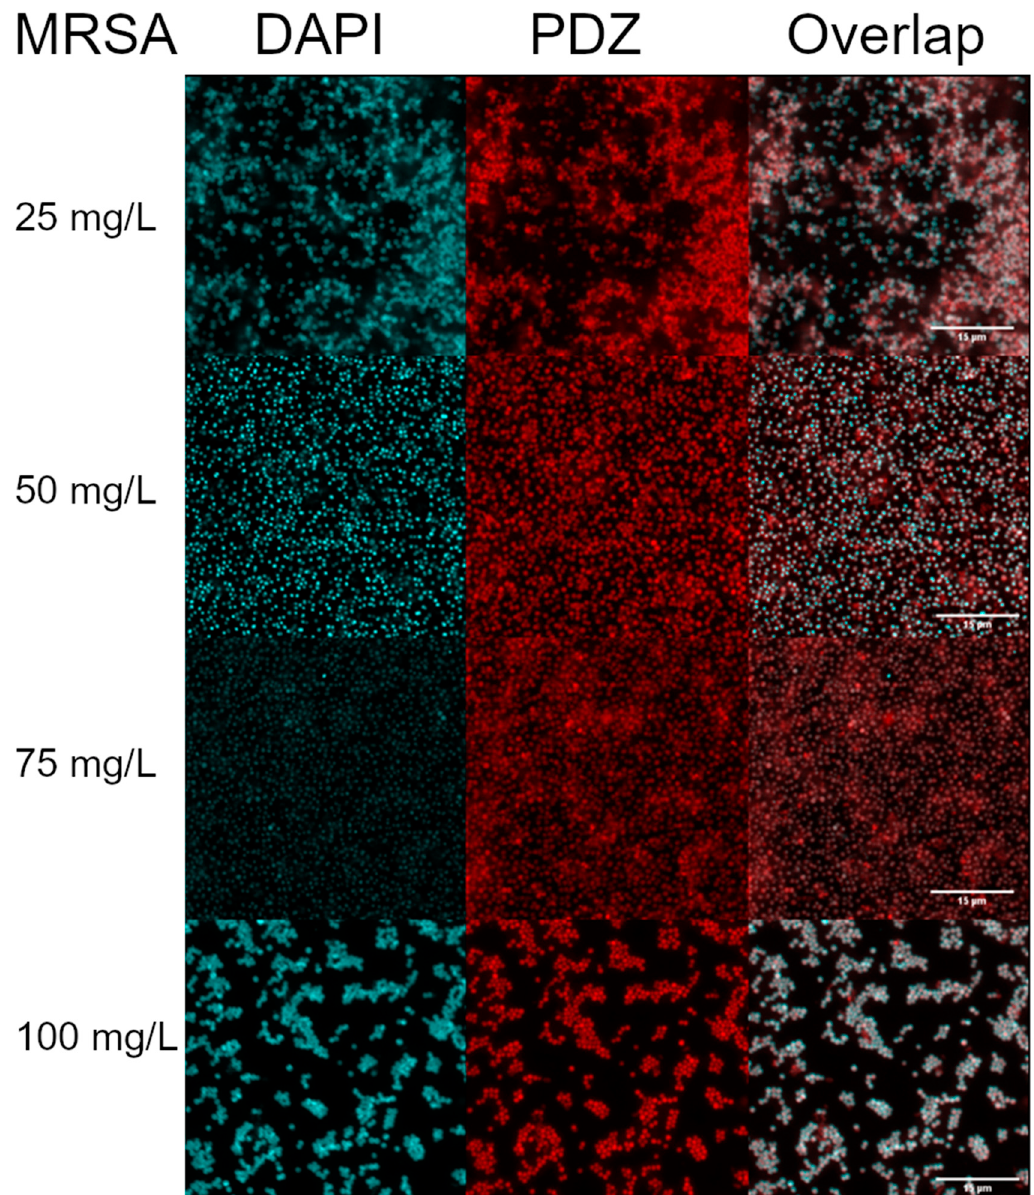
Figure 2. Internalization of PDZ in MRSA strains at 100, 75, 50, and 25 mg/L after 15 min of incubation, observed under Confocal Microscopy. The marking of the bacterial DNA with DAPI is observed in blue, and the PDZ interaction with bacterial strains in red, as well as the overlapping of signals.